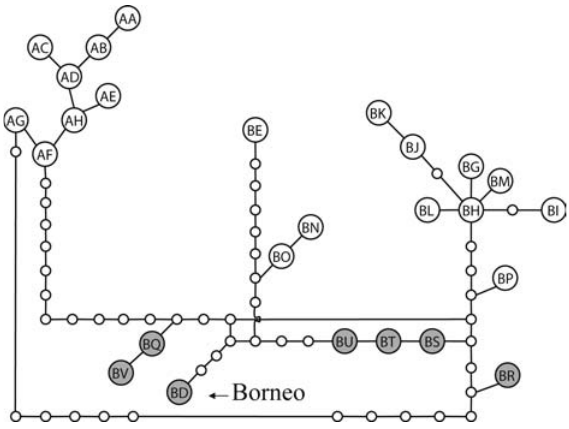
Figure 4. Network of Asian Elephant Haplotypes Based on Statistical Parsimony Grey circles with letters denote haplotypes unique to the Sunda region (BD: Borneo; BQ, BV: peninsular Malaysia; BR, BS, BT, BU: Sumatra). White circles with letters denote haplotypes found in mainland Asia (excluding peninsular Malaysia) and Sri Lanka. The small open circles denote hypothetical haplotypes. Haplotypes beginning with the letters A and B belong to the two clades a and b , respectively. DOI: 10.1371/journal.pbio.0000006.g004